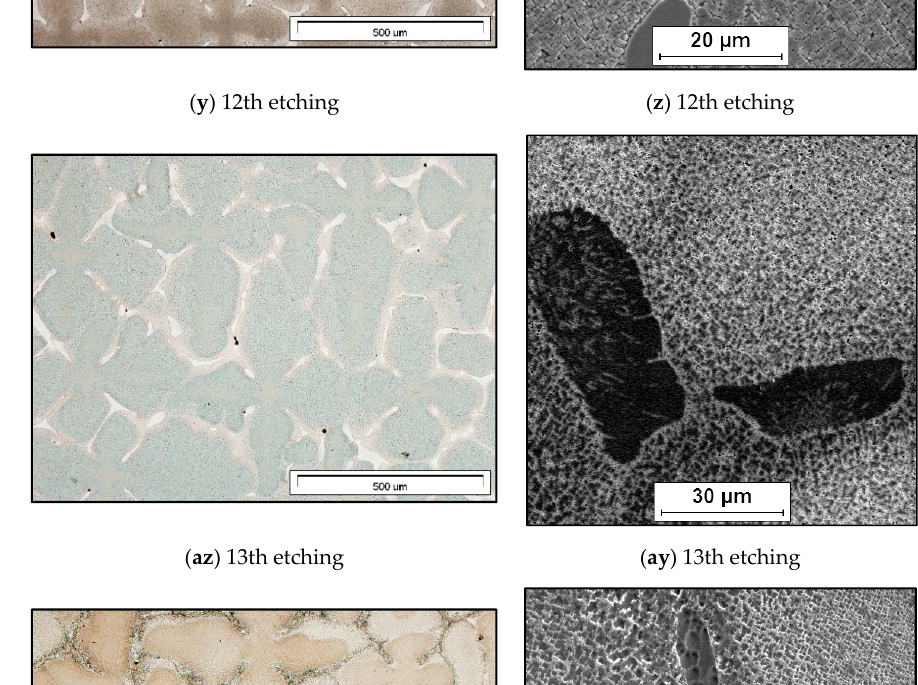
interdendritic regions with a coarser γ / γ ' structure, pools of γ / γ ' eutectic and coarse γ ' islands